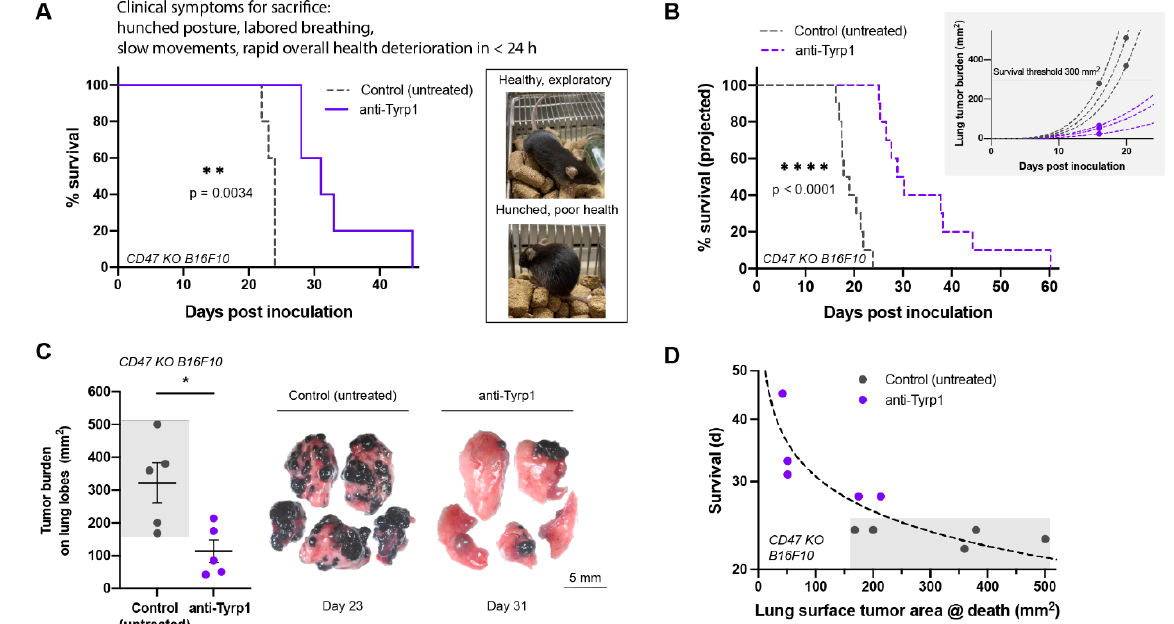
Figure 4. Tumor clearance induced by opsonization AND CD47 deletion prolongs survival, but a few large tumor masses still cause death. ( A ) Survival of anti-Tyrp1-treated mice induced with 2 × 10 5 CD47 KO B16F10 cells intravenously. 250 µ g anti-Tyrp1 doses beginning on Day 4 post inoculation prolong the survival of mice by about 30%, but mice are unable to be cured completely ( n = 5 per group, ** p < 0.01, Log-rank test). Right: mice are healthy and exploratory, then rapidly deteriorate in health in less than 24 h, showing clinical symptoms of hunched posture, labored breathing, slow reactivity, and weight loss. ( B ) Projected survival of anti-Tyrp1-treated mice induced with 2 × 10 5 CD47 KO B16F10 intravenously modeled with a power law fit based on single timepoint estimates of growth. With 75 µ g of anti-Tyrp1 on the same dosing timeline, the estimated projected survival advantage is ~6–7 days ( n = 10 per group, **** p < 0.0001, Log-rank test). Inset: exponential-type growth projections of six representative mice. ( C ) CD47 KO B16F10 tumor burden on lung lobes at sacrifice. Anti-Tyrp1-treated mice have lungs with markedly reduced tumor burden relative to untreated mice, yet demonstrate similar clinical symptoms, requiring sacrifice ( n = 5 per group, * p < 0.05, unpaired t-test). ( D ) Survival of mice in days versus lung surface tumor area at sacrifice. An exponential-type model shows that survival is inhibited by lung tumor